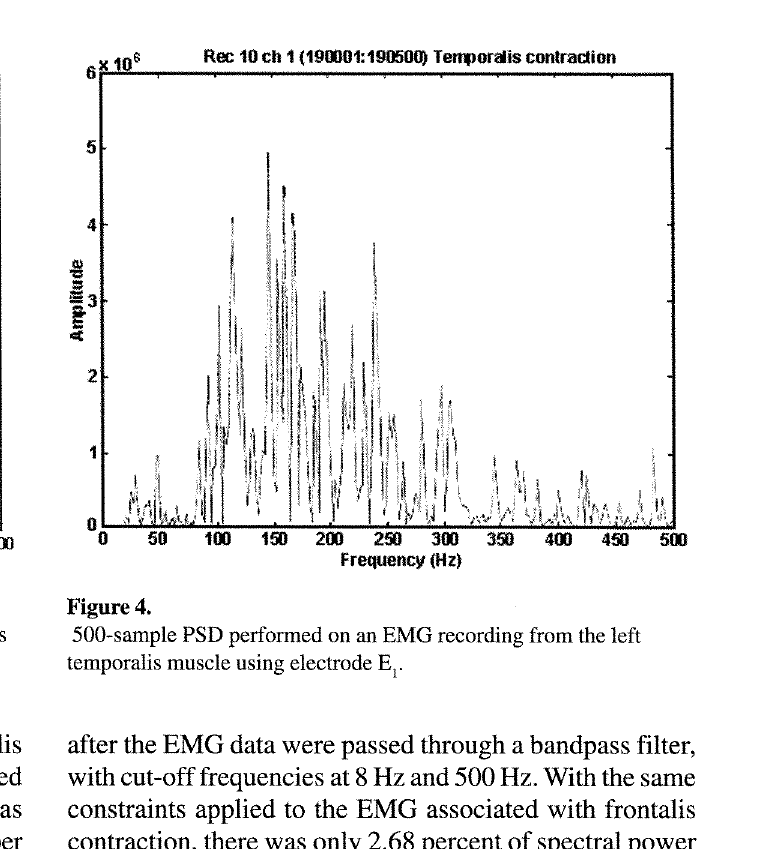
500-sample PSD performed on an EMG recording from the frontalis muscle using electrode Eo.